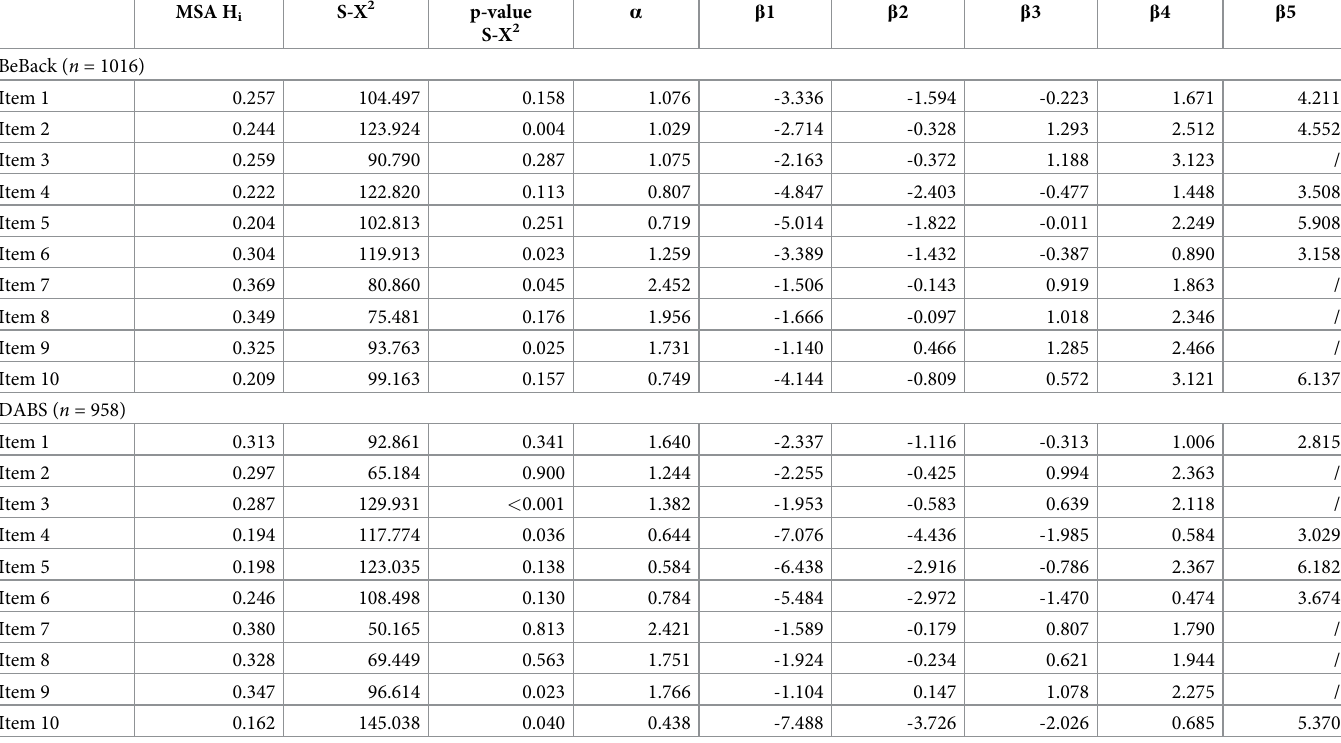
Table 3. Results of item response theory analysis, including scalability coefficients, item fit statistics, and item parameters for the 10 items of the biomedical scale of the Pain Attitudes and Beliefs Scale (PABS). MSA H